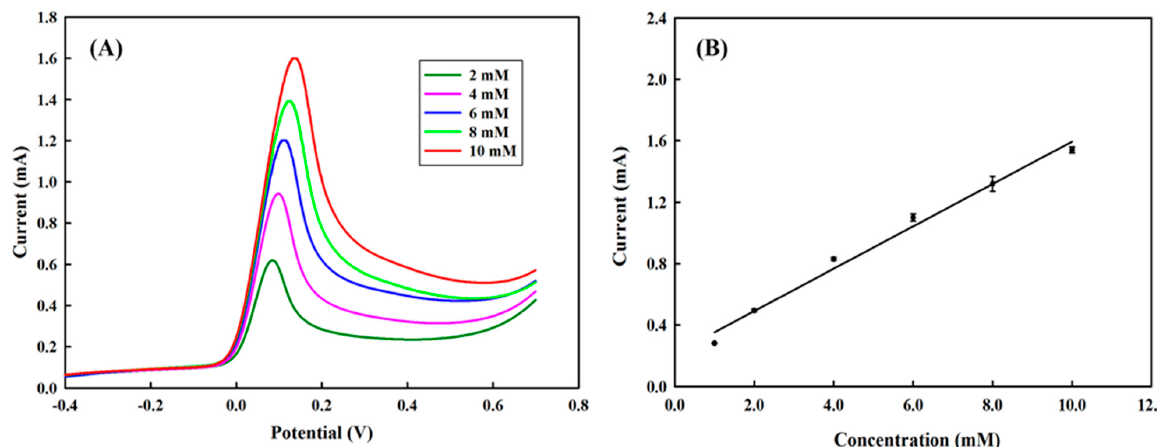
Figure 10. ( A ) The LSV profiles of PEDOT/PL electrode in response to different concentrations of hydroquinone (2 to 10 mM). The measurements were carried in 100 mM of PBS buffer. The potential was swept from − 0.5–0.7 V with the rate of 100 mV s − 1 . ( B ) The linear correlation between the anodic peak current and the concentration of hydroquinone.